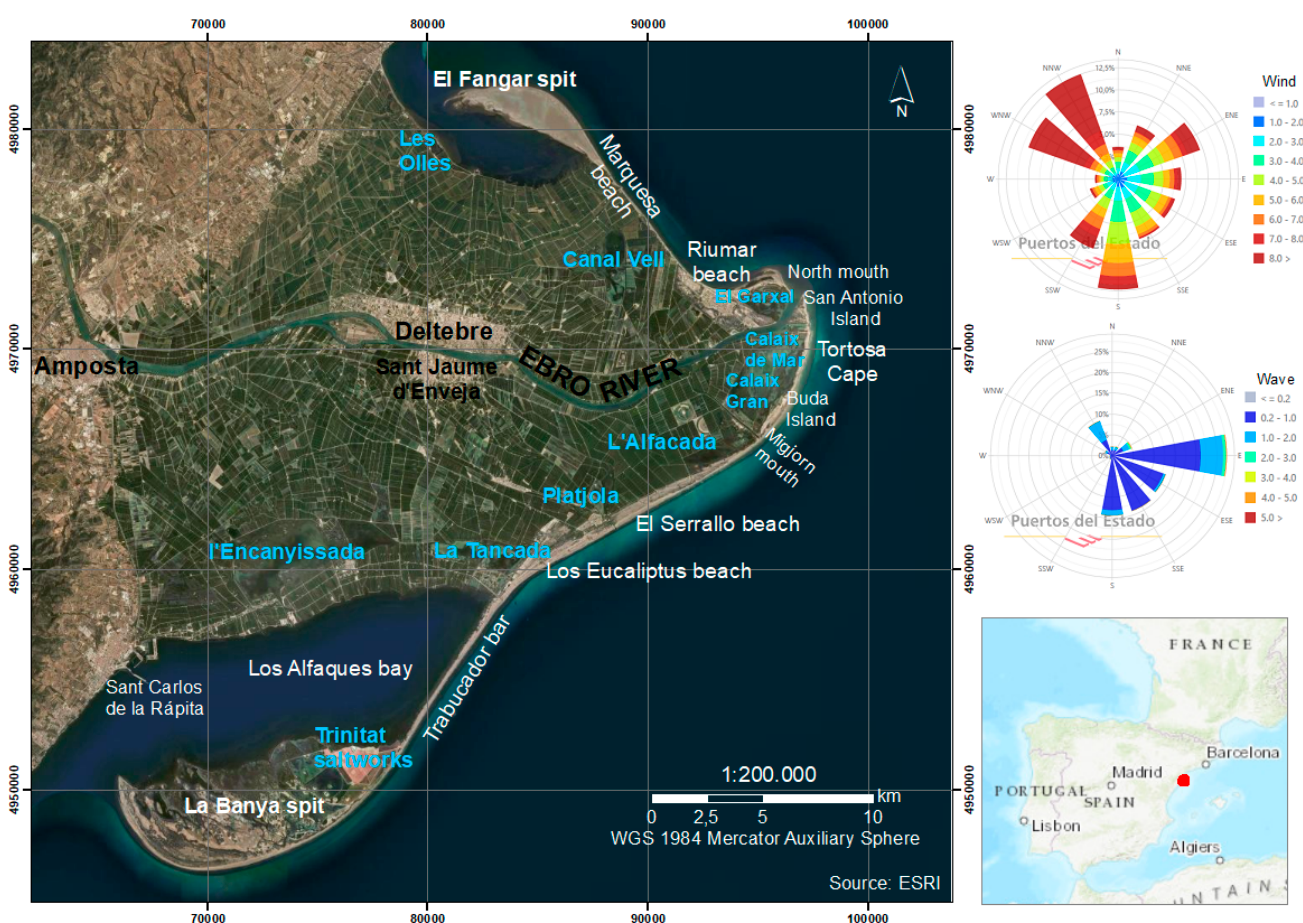
Figure 1. Location of the main geomorphologic elements. The lagoons are represented in blue. The wind rose (average wind speed (m/s)) and the wave rose (significant wave height (m)) are displayed on the right. Source: Puertos del Estado (www.puertos.es/es-es (accessed on 5 October